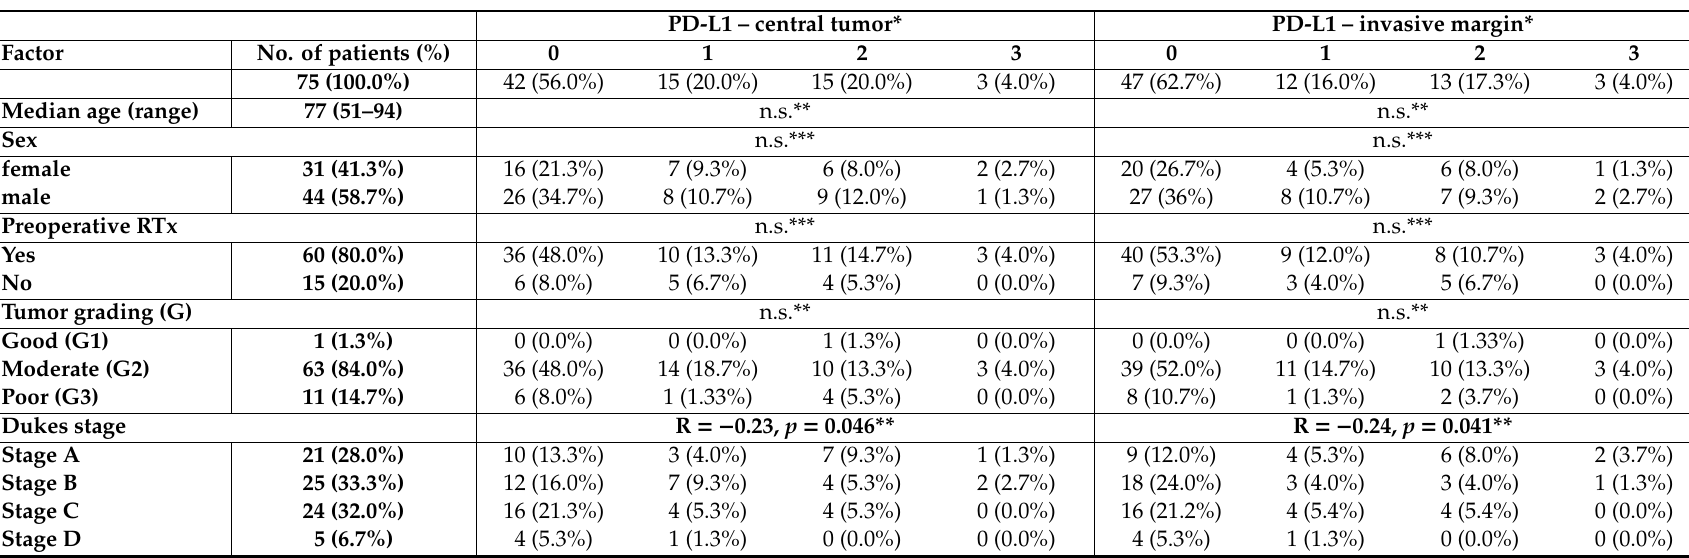
Table 4. Patient and tumor characteristics in relation to the level of PD-L1 immune checkpoint protein expression determined analogously on full tissue sections. PD-L1 – central tumor* PD-L1 – invasive